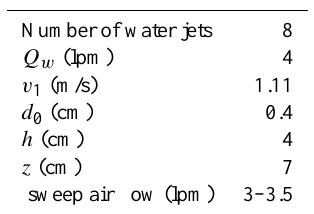
Table 4. Summary of experimental conditions in the multiple plunging water jet system employed in this study. Q w =total wa- ter flow, v 1 =mean jet velocity at the water surface, d 0 =nozzle di- ameter, h =vertical distance from the nozzle to the water surface, z =penetration